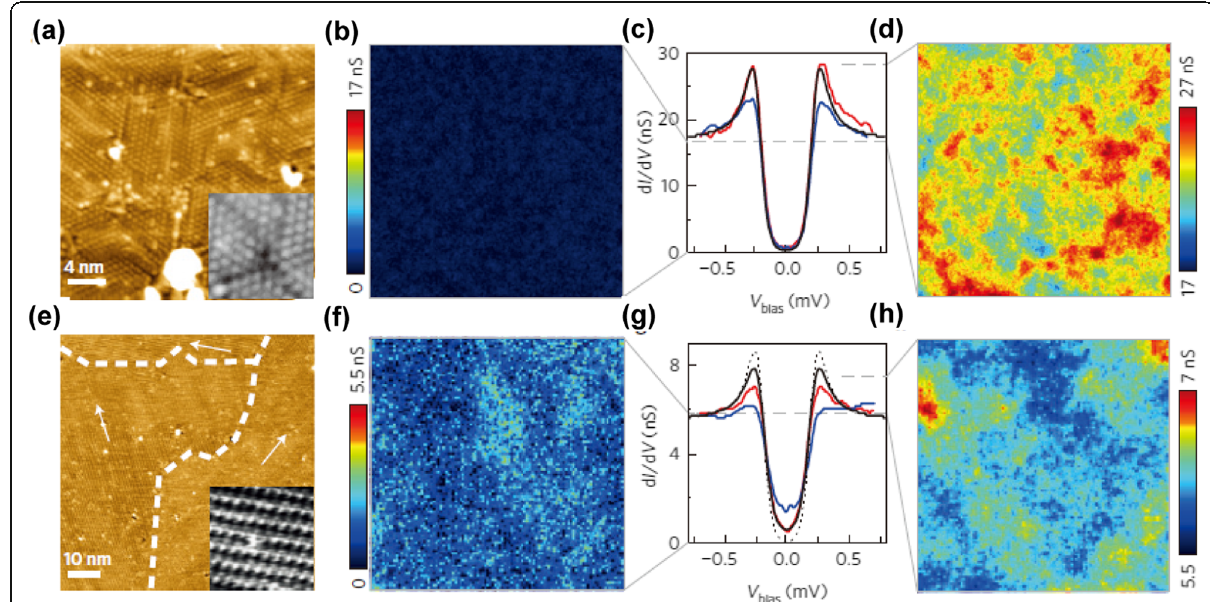
Fig. 8 STM measurements taken for Si(111)-SIC-Pb ( a – d ) and Si(111)-( √ 7× √ 3)-Pb ( e – h ). a , e Topographic images. b , f Zero-bias dI/dV maps corresponding to the superconducting energy gap. c , g Representative local dI/dV spectra. d , h dI/dV maps at biases of 0.29 mV ( d ) and 0.26 mV ( h ), corresponding to the energy of the quasiparticle peaks in the tunneling spectra. Reprinted by permission from Macmillan Publishers Ltd.: C. Brun et al. Nat. Phys. 10 , 444 – 450 (2014) [14], copyright 2014.